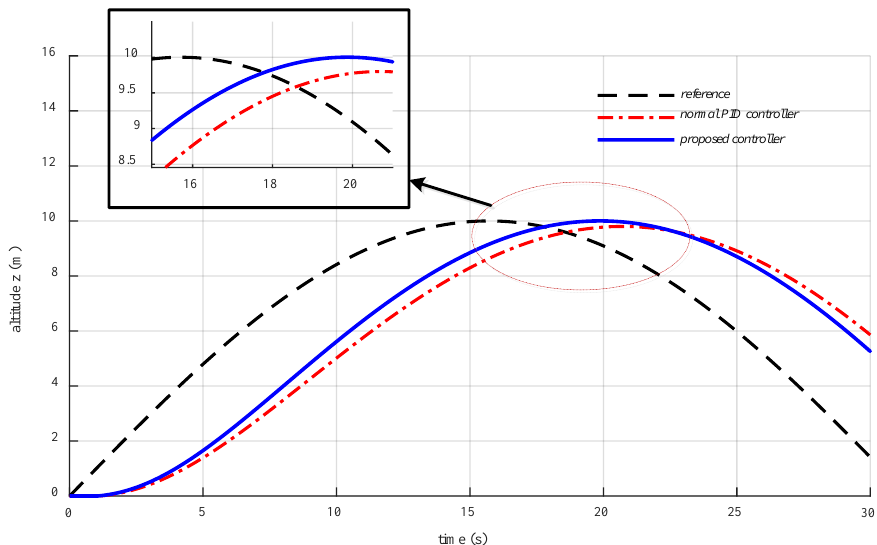
Figure 12. Comparison of altitude performances between our new controller and a conventional PID controller for Scenario 2 (tracking a moving altitude reference).